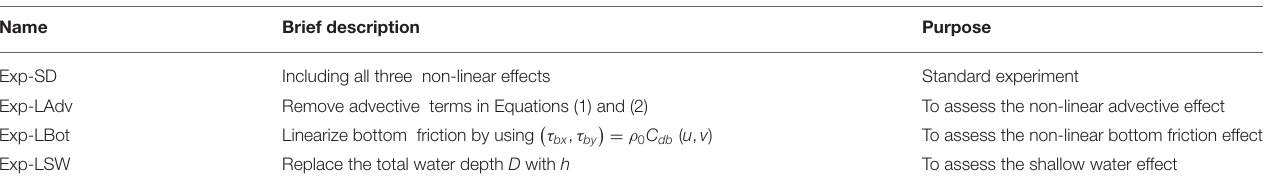
FIGURE 8 | Spatial distributions of (A) the maximum positive magnitude of ζ TSI , i.e., MAX( ζ TSI ), (B) the root-mean-square of ζ TSI , i.e., RMS( ζ TSI ), and (C) the ratio I r , RMS ( ζ SO ) ∗ RMS ( ζ TO ), in the PRE during the passage of Typhoon Hato. which is defined as I r = RMS ( ζ TSI ) / p TABLE 2 | The “subtraction” numerical approach used to study the mechanisms of tide-surge